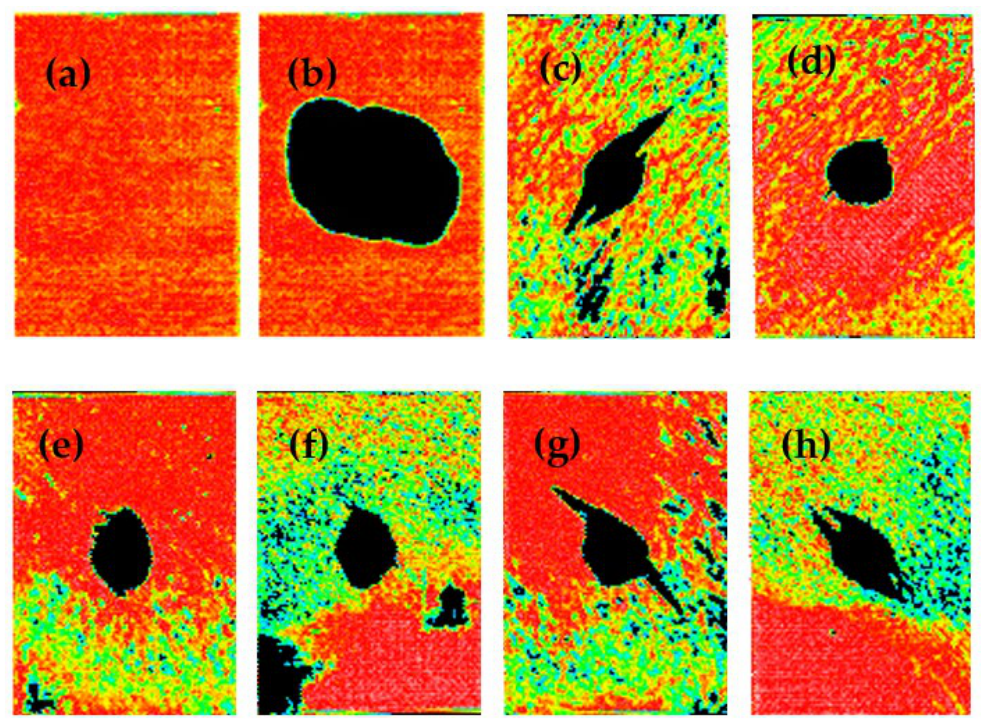
Figure 7. Images of ( a , b ) the bifunctional CF fabrics treated at 80 ℃ /45 min in vacuum for the pre- forming evaluation.